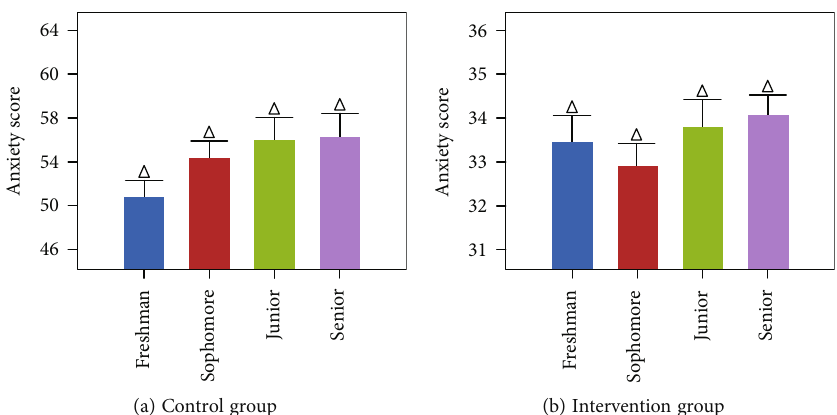
Figure 2: Anxiety evaluation results of college students with di ff erent grades in the control and intervention groups after